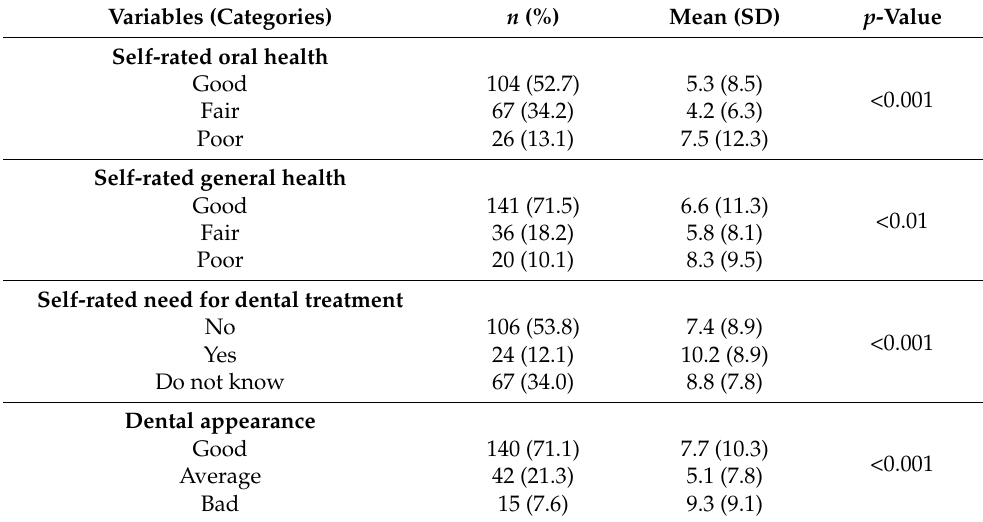
Table 3. Findings for the construct validity of the C–OIDP-U.